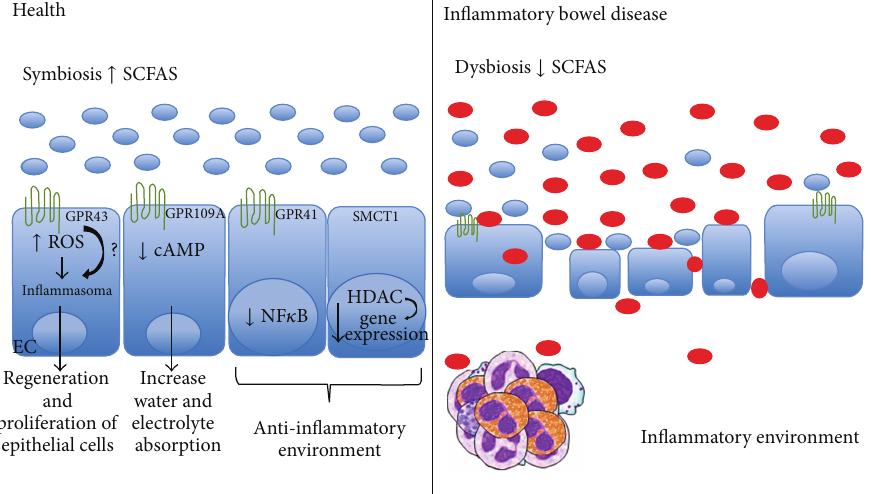
Figure2:Schematicrepresentationofacomplexmucosalimmunesystemcomposedofepithelialandhematopoieticcellsthatareabletoreact to pathogenic insults. Development of IBD occurs mainly when epithelial cells are damaged and/or the intestinal microbiota composition is not